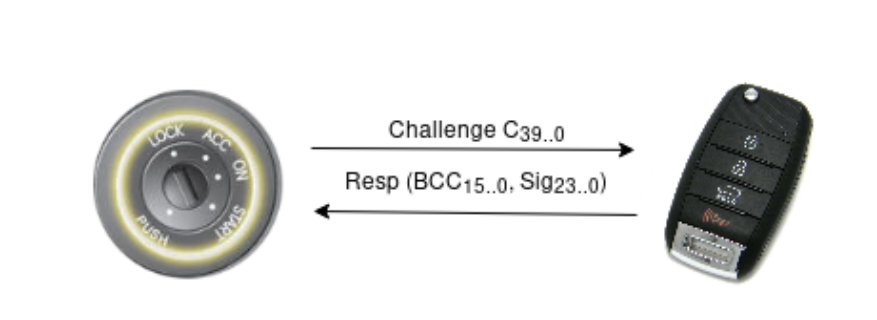
Figure 2: The DST80 authentication